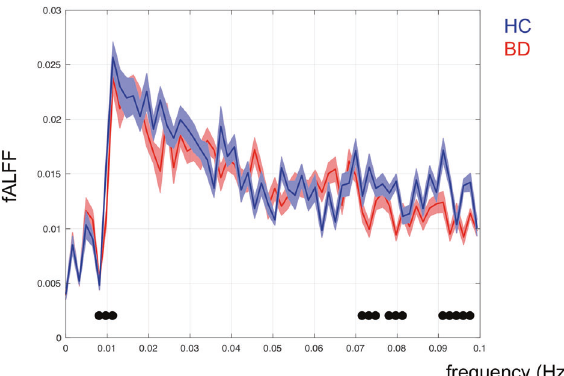
Fig. 2 LN fALFF in HC and BD patients. Normalized fALFF analysis carried out on LN time series in BD patients and HC (red and blue lines, respectively).